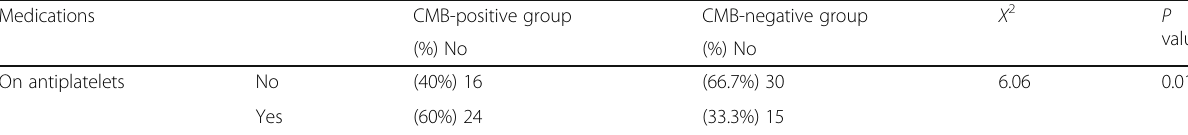
Table 2 Antiplatelet intake differences between CMB-positive and CMB-negative groups Medications